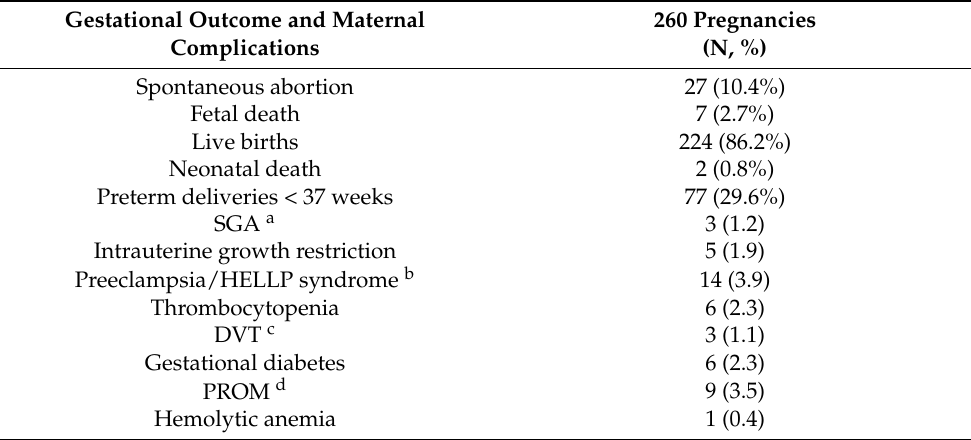
Table 1. Outcome and APO of the study cohort.